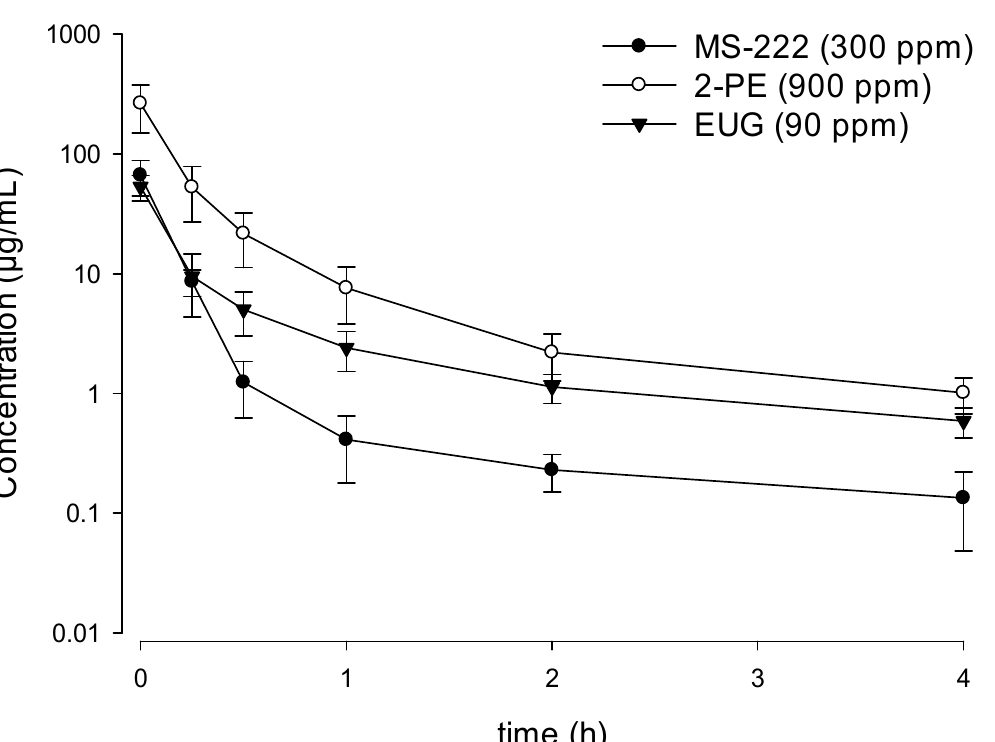
Figure 3. Serum concentration time profile (mean ± SD) of tricaine methanesulfonate (MS-222), 2-phenoxyethanol (2-PE), and eugenol (EUG) in Nile tilapia during the recovery phase following immersion at the optimal doses at 28 °C ( n = 7).